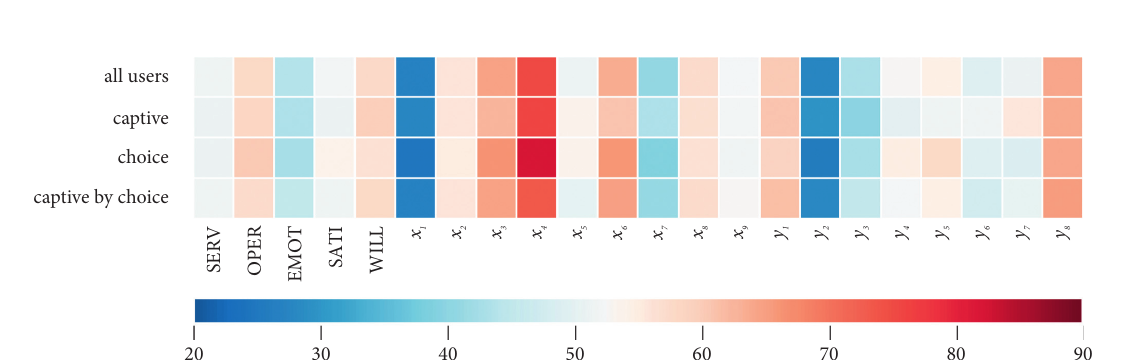
Figure 5: Index scores of the general and comparison